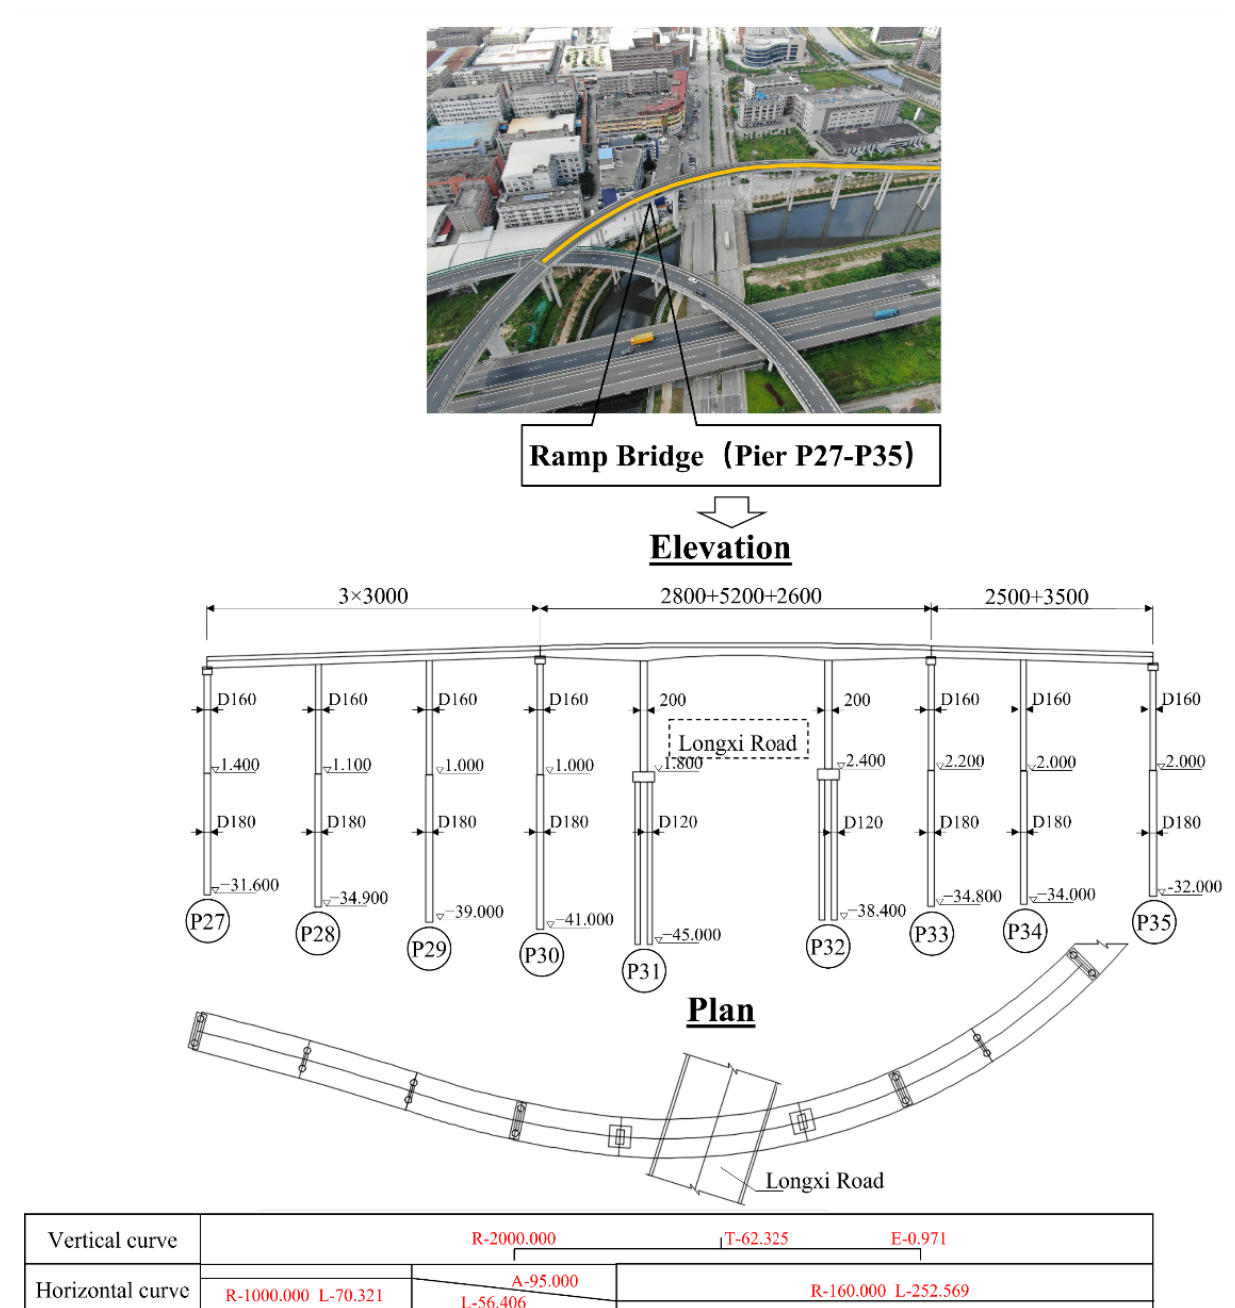
Figure 1. Longxi Interchange of Guangzhou–Zhongshan–Jiangmen Expressway.